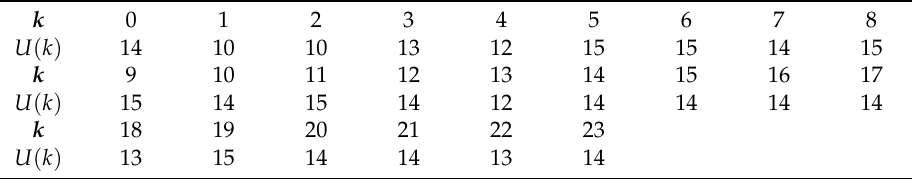
Table 5. Optimal production plan yielded by the differential evolution (DE) method.